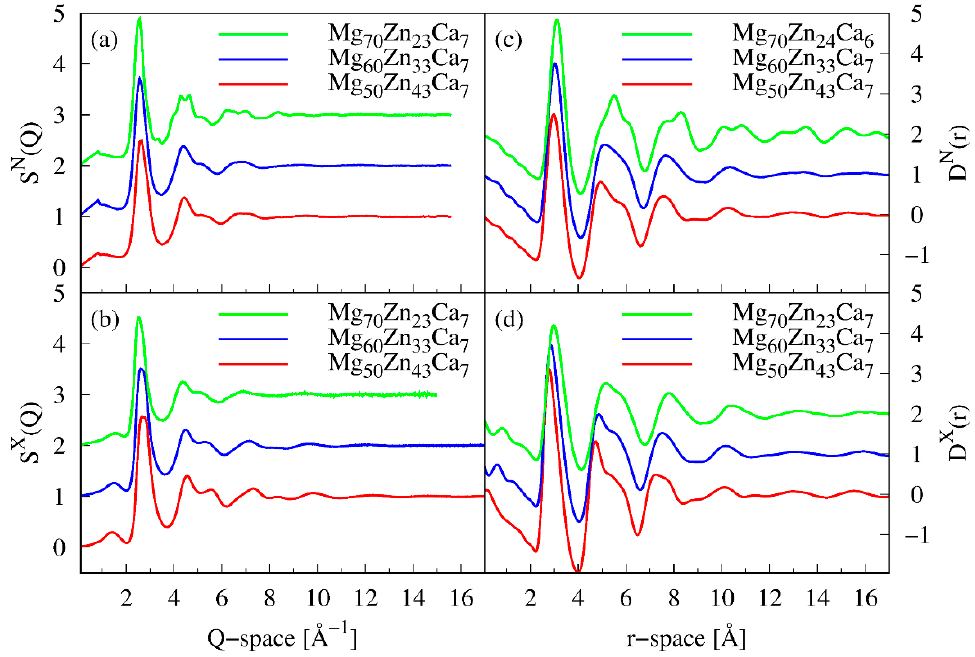
Figure 2. ( a ) Neutron and ( b ) X-ray structure factors and corresponding ( c ) neutron and ( d ) X-ray reduced pair distribution functions for Mg 70 Zn 23 Ca 7 , Mg 60 Zn 33 Ca 7 , and Mg 50 Zn4 3 Ca 7 (from top to bottom). Individual curves are vertically offset for clarity reasons. Table 2. Total coordination numbers, N X and N N , calculated in the range of 2.3 Å to 4.0 Å from D X ( r ) and D N ( r ) functions, respectively.